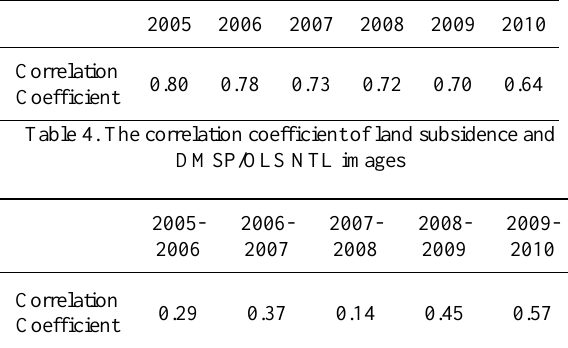
Table 5. The correlation coefficient of land subsidence and Figure 5 . The trends of normalized urbanization variables and WLA